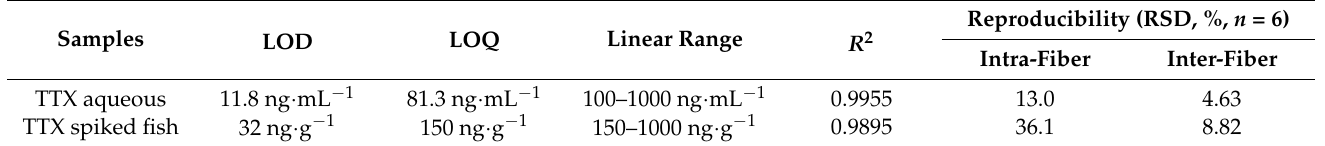
Reproducibility (RSD, %, n = 6)